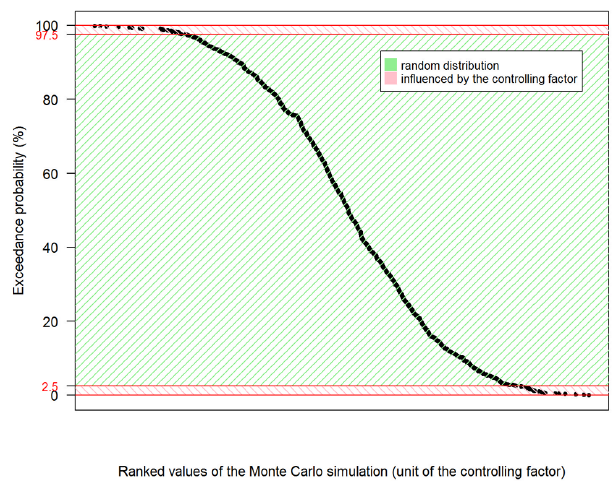
Fig. 2. Plot of the exceedance probability against theoretical ranked randomly sampled values with a confidence interval of